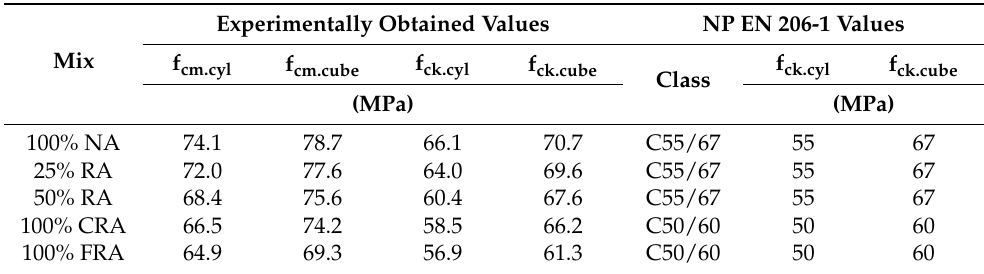
Table 6. Compressive strength classes determined according to NP EN 206-1 [31] (PC 65).